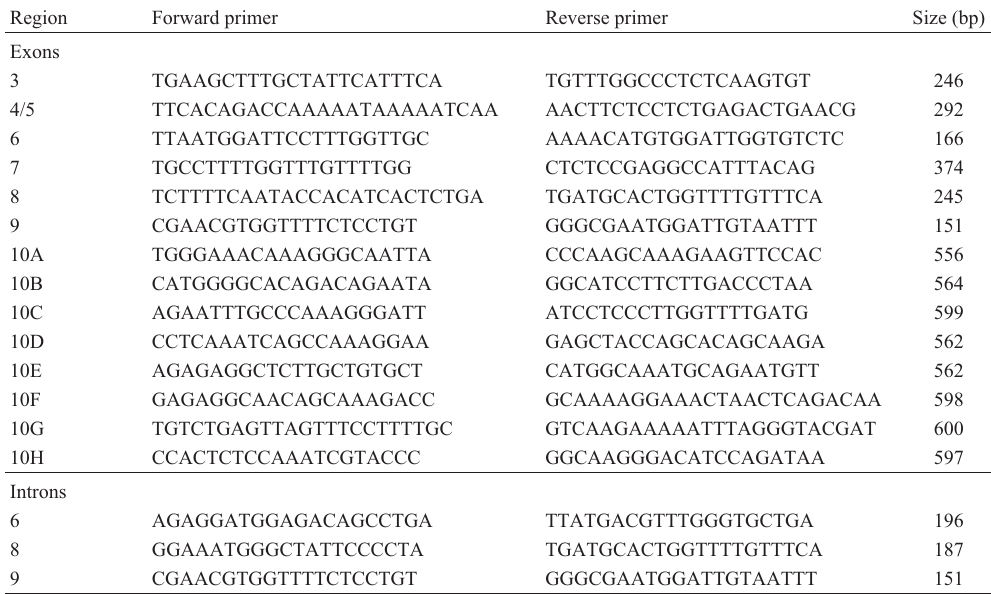
Table 3 - Primers used for ENAM gene amplification.